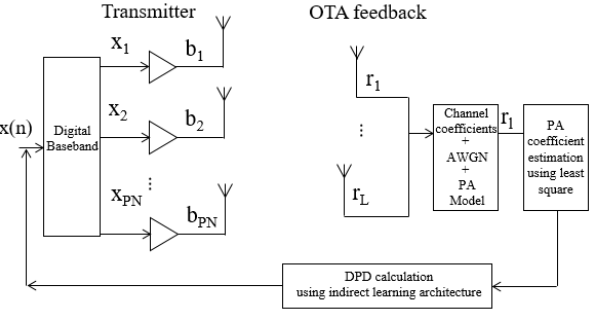
Figure 4. Block diagram representing the steps to apply the modeling and linearization of multi- antenna transmitters using OTA measurements method.